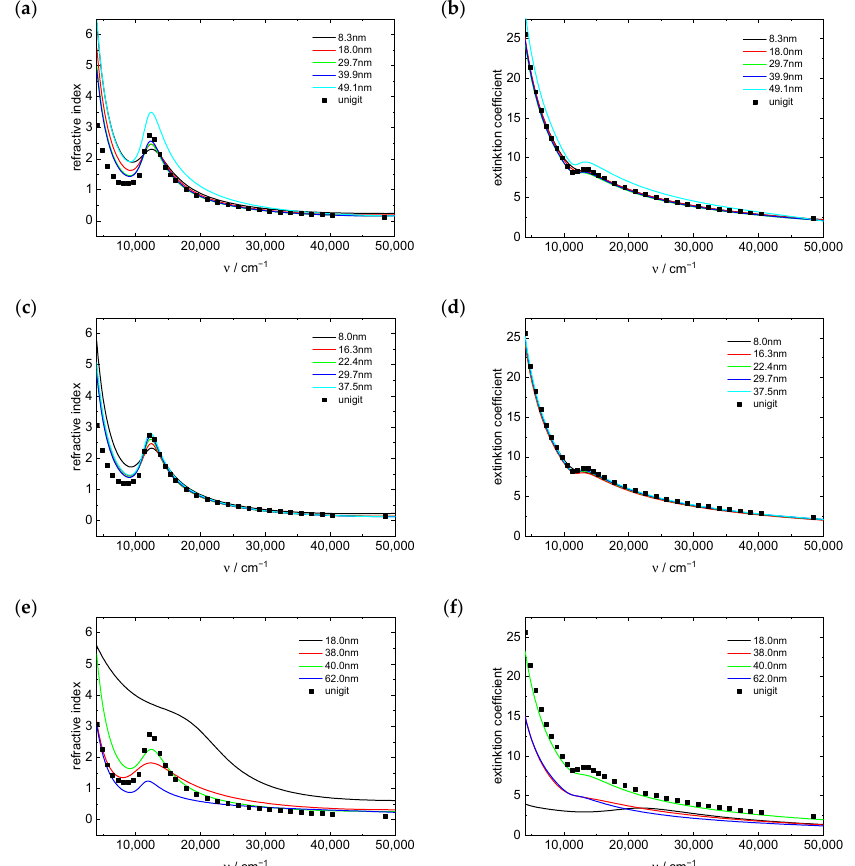
Figure 8. Optical constants for sputtering series 1 ( a , b ), evaporation series 2 ( c , d ) and assisted evaporation series 3 ( e , f ); left: n; right: k.